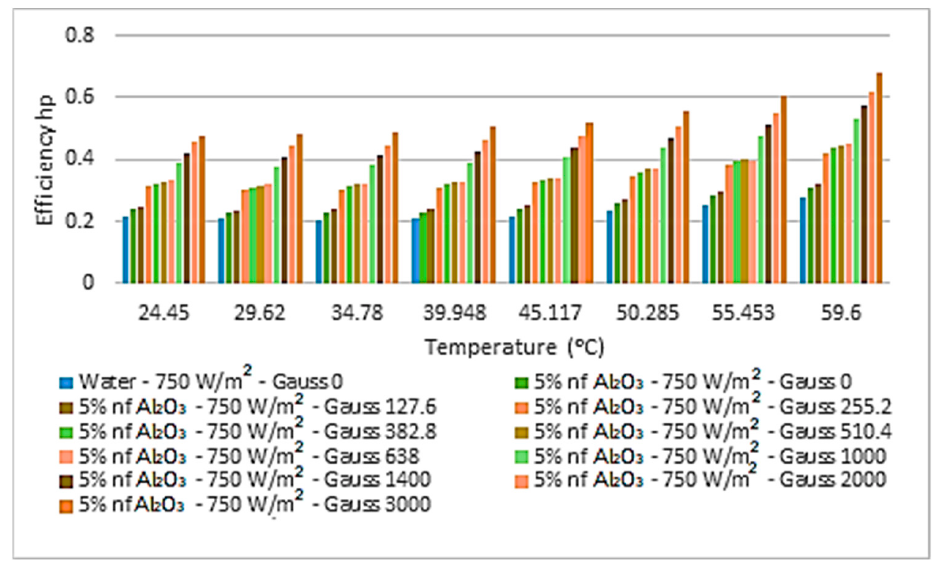
Figure 7. Thermal efficiency of heat pipe evaporator with PV-Th solar panels.